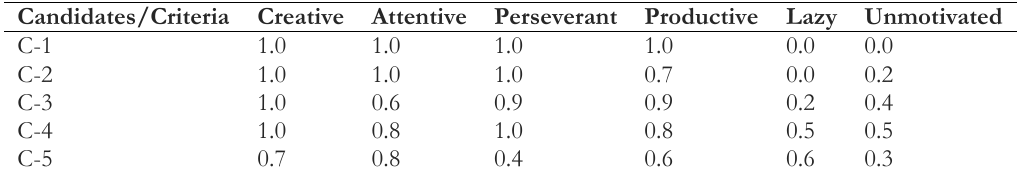
Table 4. Mean values of fuzzy membership degrees of the characteristics of five candidates in the first time span in the decision matrix.